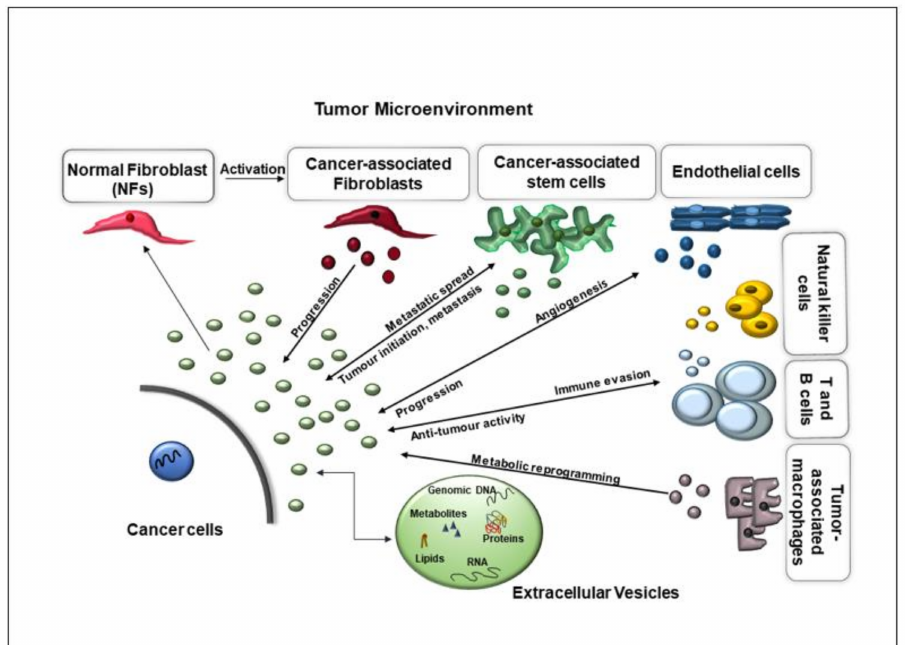
Figure 1. Schematic illustration of EV-mediated interactions between cancer cells and their TME. In cancer, EVs are involved in the process of transporting bioactive molecules between stromal and transformed cells, including endothelial, mesenchymal, immune, and CAF cells. Several subtypes of immune cells can also be found in the TME, including dendritic cells (DCs), B and T lymphocytes, and macrophages. EVs released within TME contribute to TME heterogeneity by creating a suitable environment for tumor growth, progression, and metastasis. EVs derived from immune cells which exhibit anti-cancer activity are an exception. Modified from